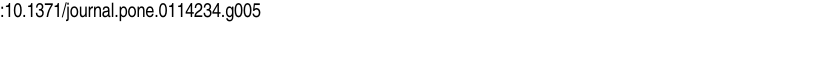
Fig. 5. Angular histogram of alignment strategy 1 (period-adaptive